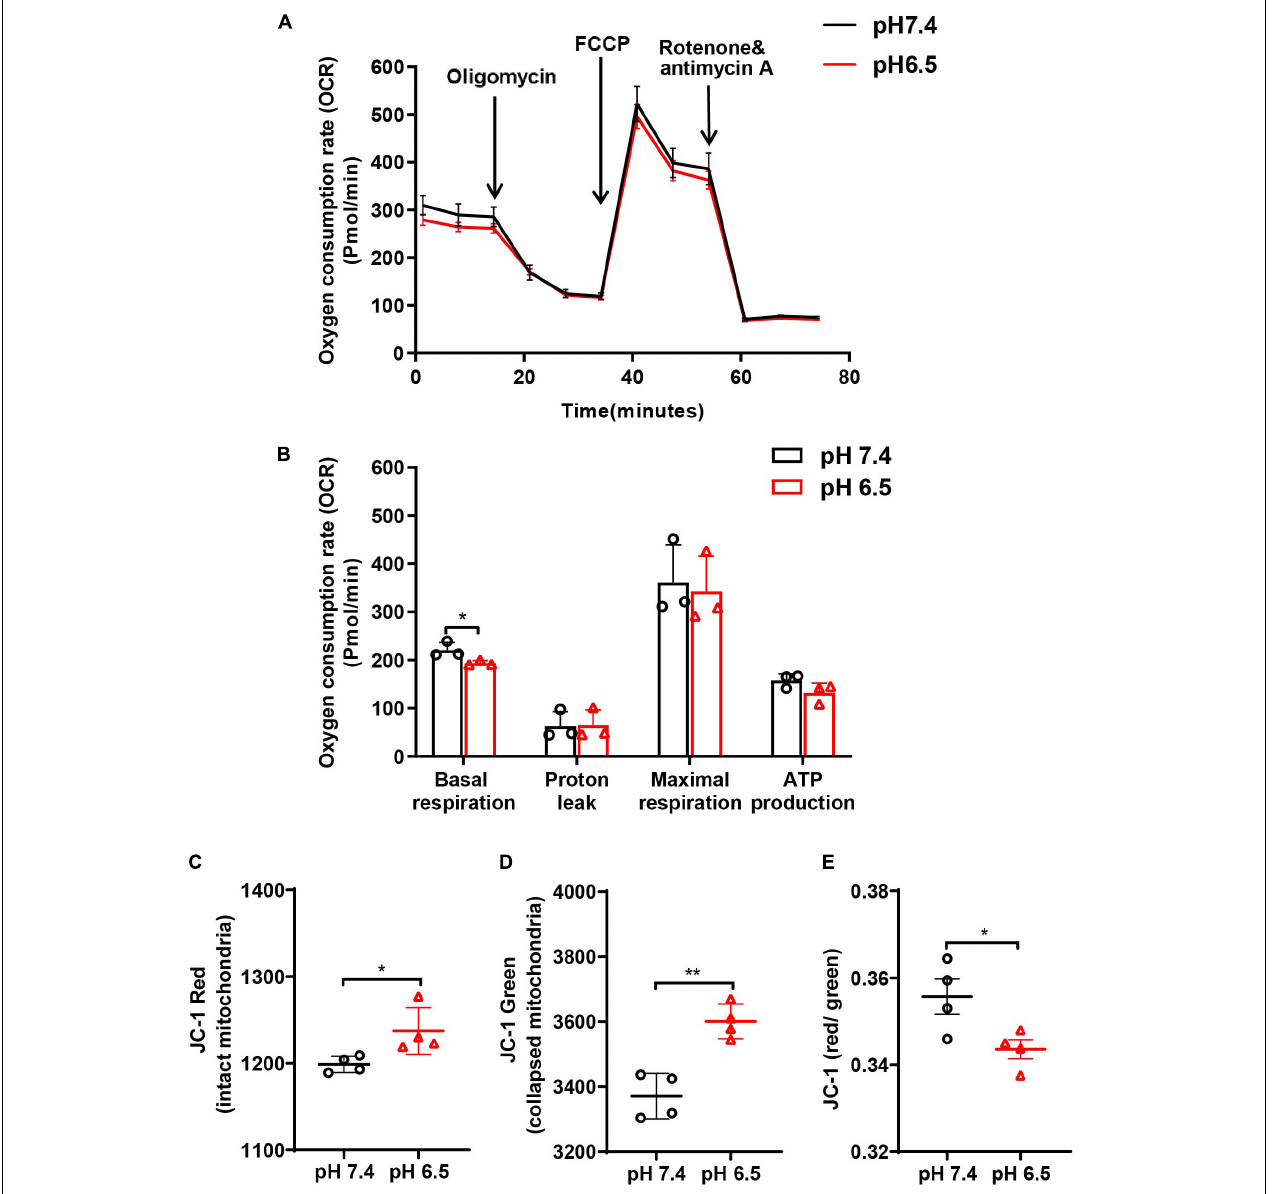
FIGURE 4 | Oxygen consumption rate (OCR) and mitochondrial membrane potential ( (cid:49) ψ m; JC-1 red/green ratio) were performed to examine the function of neuronal mitochondria following acidosis. (A) Representative OCR traces ± SD measured in neurons treated with pH 6.5 and 7.4 solutions. (B) Quantification of basal, “leak,” “maximal” state, and ATP production for pH 6.5- and 7.4-treated neurons. (C–E) The JC-1 staining in neurons showed that both JC-1 red and JC-1 green increased after pH 6.5 treatment, but JC-1 red/green ratio decreased significantly. n = 4. * p < 0.05, ** p < 0.01 vs. pH